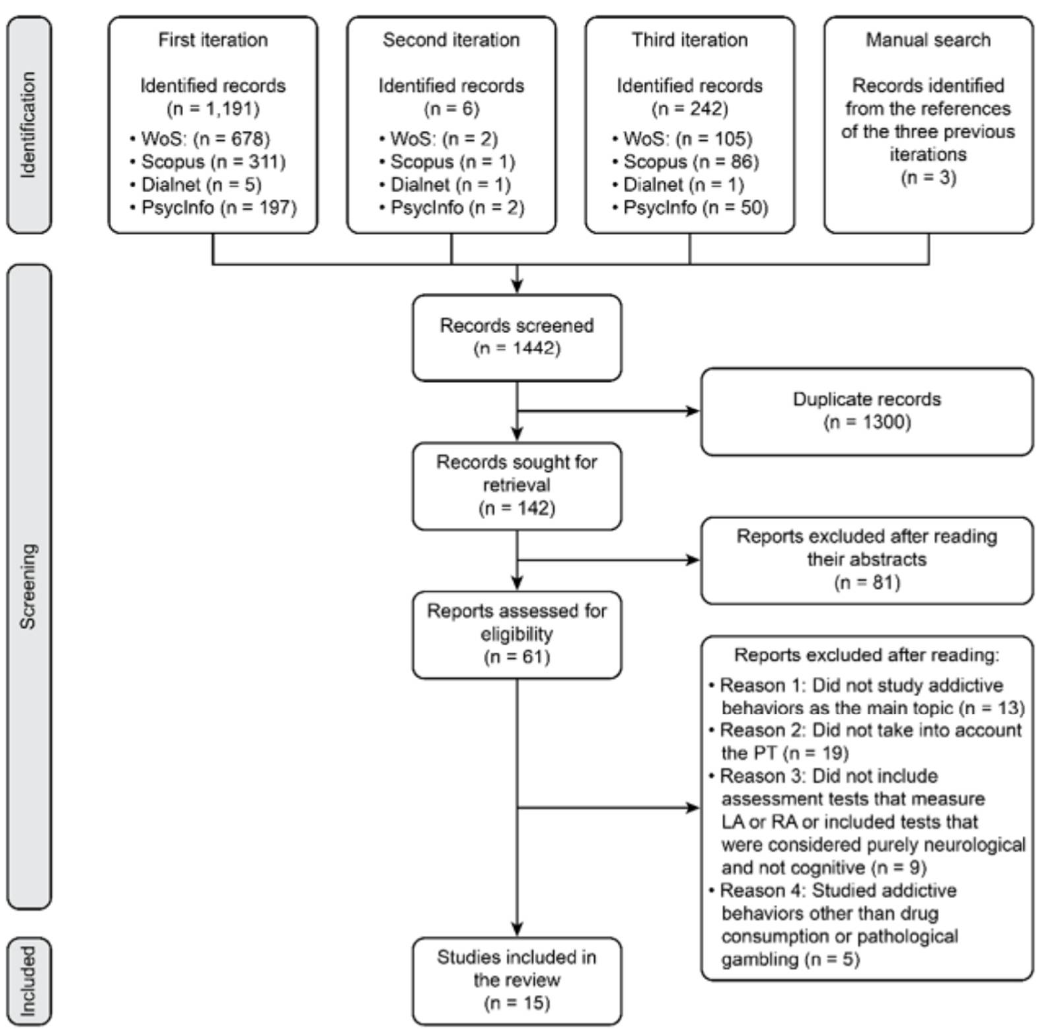
Figure 1. Flowchart of the study selection process according to PRISMA.